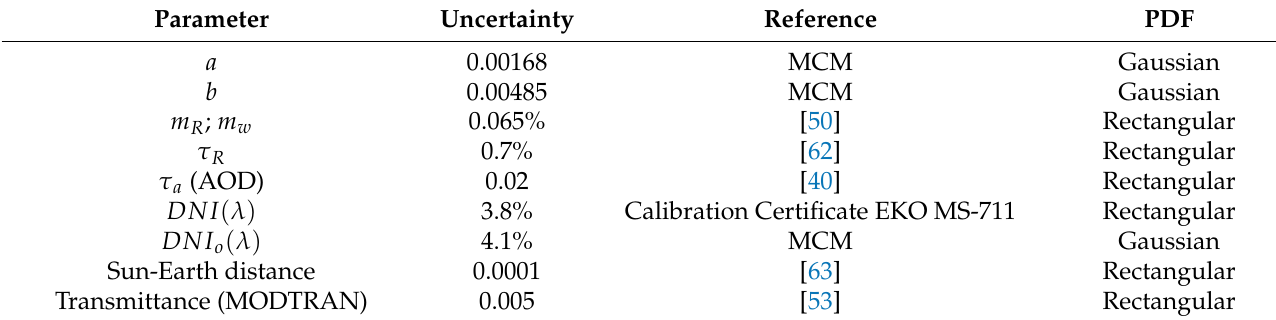
Table 1. Relative uncertainty in the input parameters, their corresponding references and the assumed probability density function (PDF). MCM: Monte-Carlo